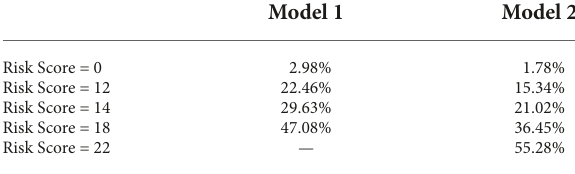
TABLE3 TheoccurrenceofMCIaccordingtothecategoriesoftheMCI risk